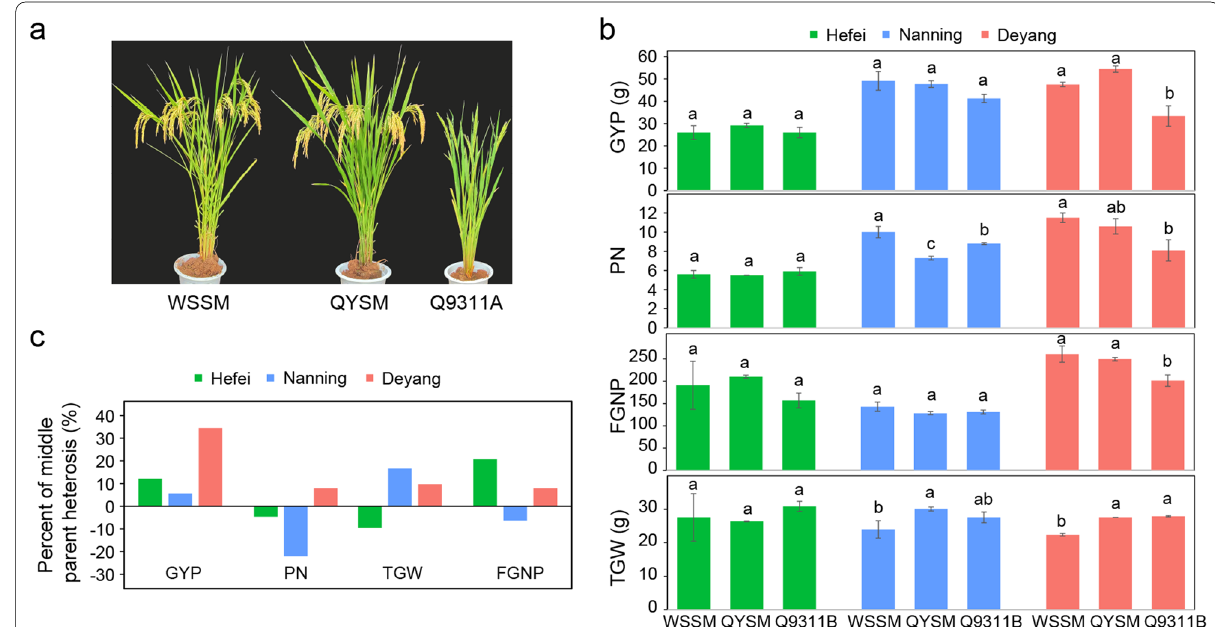
Fig. 1 Phenotypic differences and heterosis between the elite rice hybrid, Quan-you-si-miao (QYSM) and its parents. a Whole-plant morphology of QYSM and its parental lines Quan9311A (Q9311A) and Wu-shan-si-miao (WSSM). b Performance of yield-related traits in QYSM and its two parents in three environments. Different letters above the bars represent significantly differences at P < 0.05 based on Duncan’s multiple range test. c The middle parent heterosis of yield and yield component traits. GYP, grain yield per plant; PN, panicle number per plant; TGW, 1000-grain weight; FGNP, filled grain number per